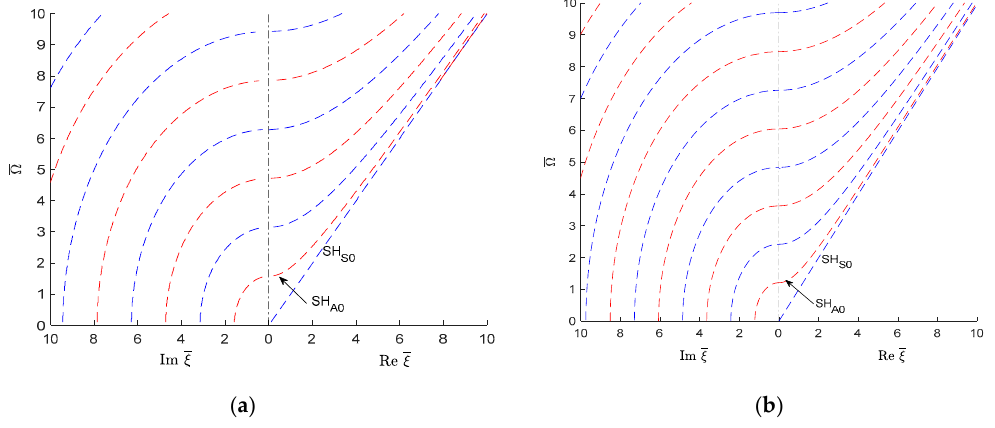
Figure 17. Real (propagating) and imaginary (evanescent) wavenumber solution of shear horizontal (SH) wave type GWs for ( a ) isotropic aluminum alloy; ( b ) unidirectional CFRP composite.